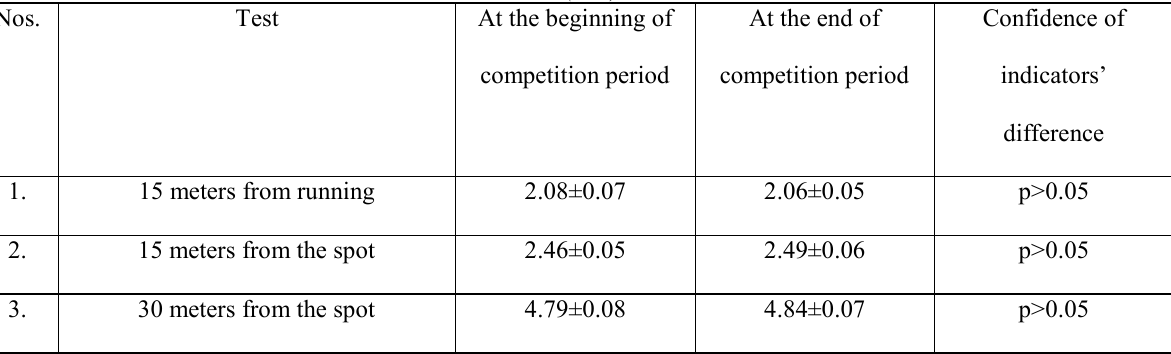
Dynamic of time of distance 15 and 30 meters covering by 13 years old football players in competition period Nos. Test At the beginning of